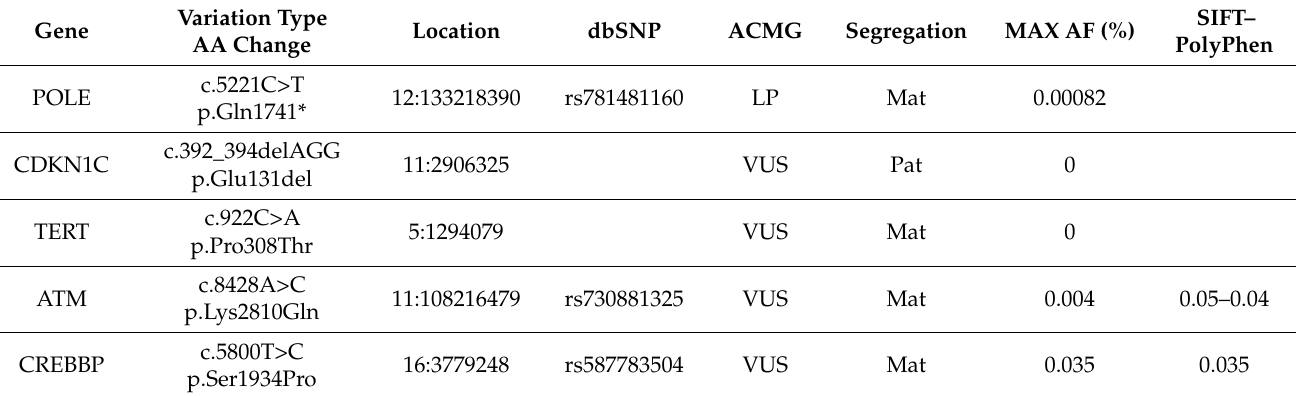
Table 3. List of genes presenting germline variants in patient’s